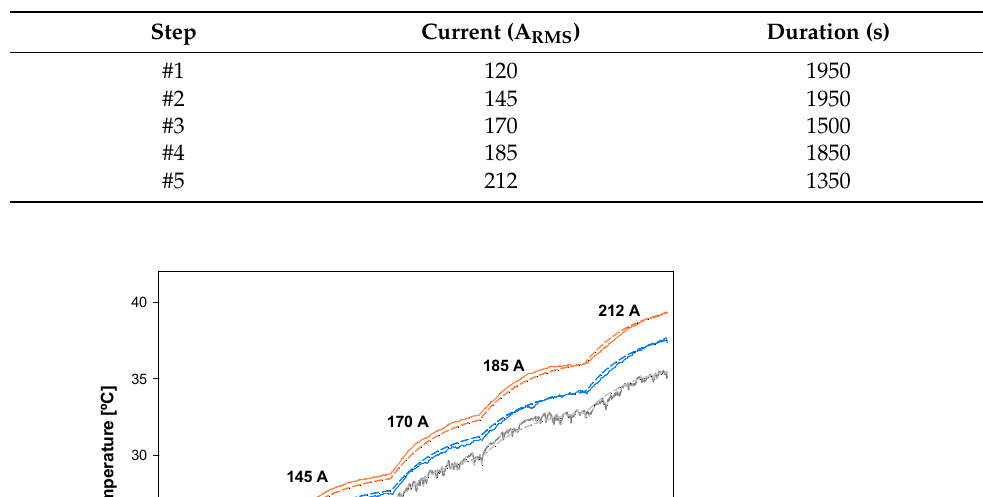
Table 2. Conductor of 70 mm 2 . Realized temperature rise tests.